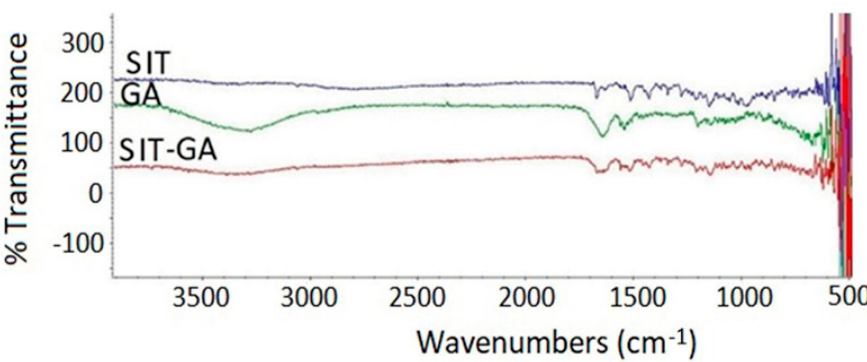
Figure 4. Fourier-transform infrared (FTIR) spectra of SIT, GA, and a SIT-GA